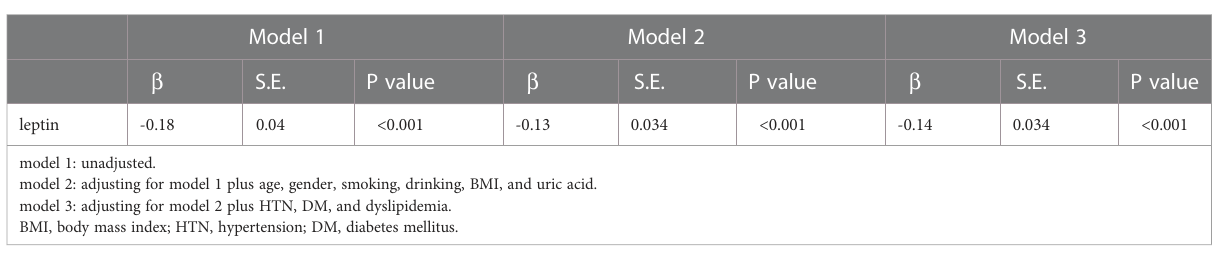
Table 2. eGFR levels were negatively correlated with serum